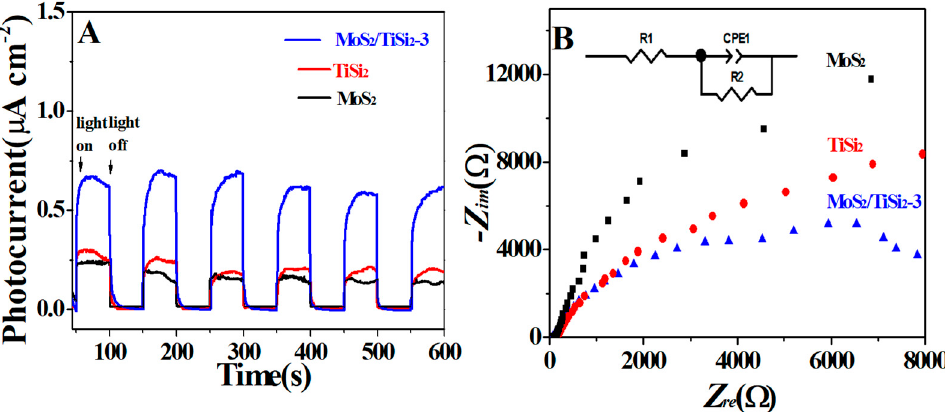
Figure 5. ( A ) The photocurrent responses of samples under 150 W xenon lamp. The electrolyte was 60 mL of 0.5 M Na 2 SO 4 solution containing 6 mL lactic acid; ( B ) The electrochemical impedance spectra (EIS) for the samples in 60 mL of 0.5 M Na 2 SO 4 solution containing 6 mL lactic acid.